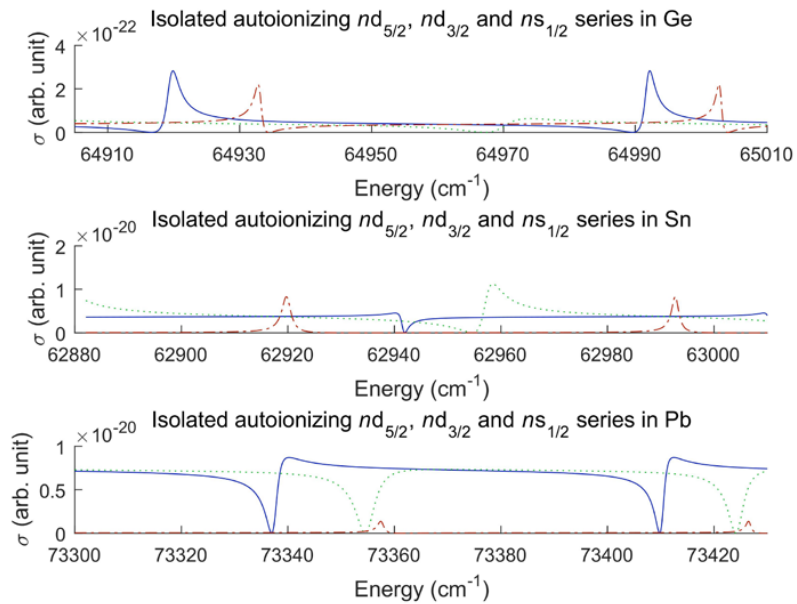
Figure 13. Isolated autoionizing Rydberg series for Ge, Sn and Pb: nd 5/2 drawn with solid, nd 3/2 with dash-dotted and ns 1/2 with dotted lines.(from [29]).